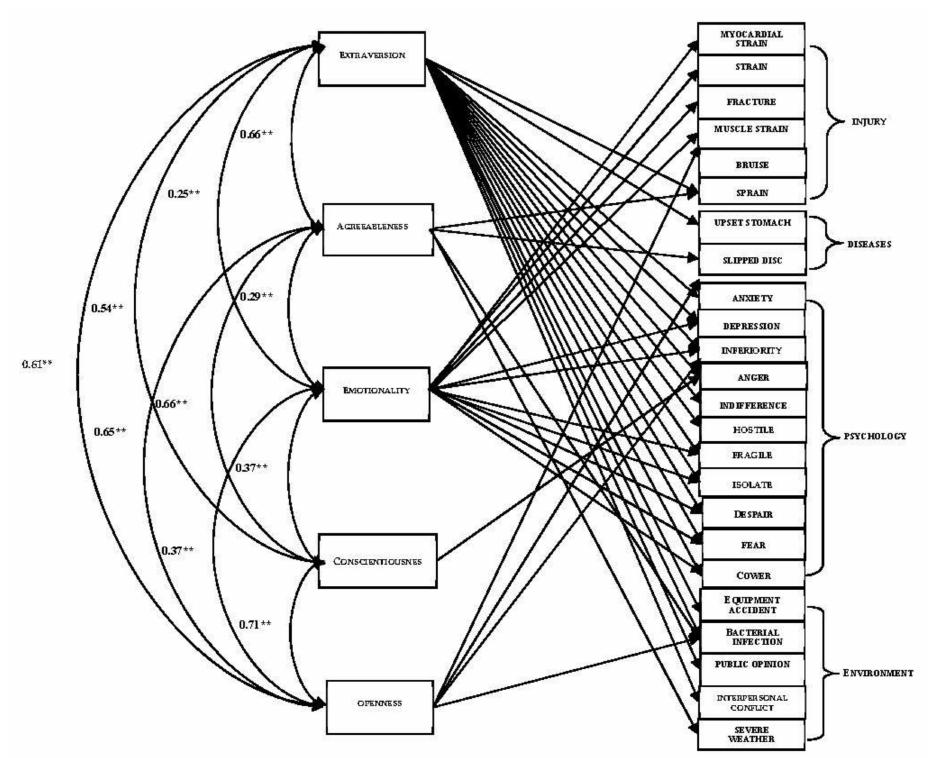
Figure 2. The correlation between personality traits and the structure of detailed risk events (** p < 0.01).